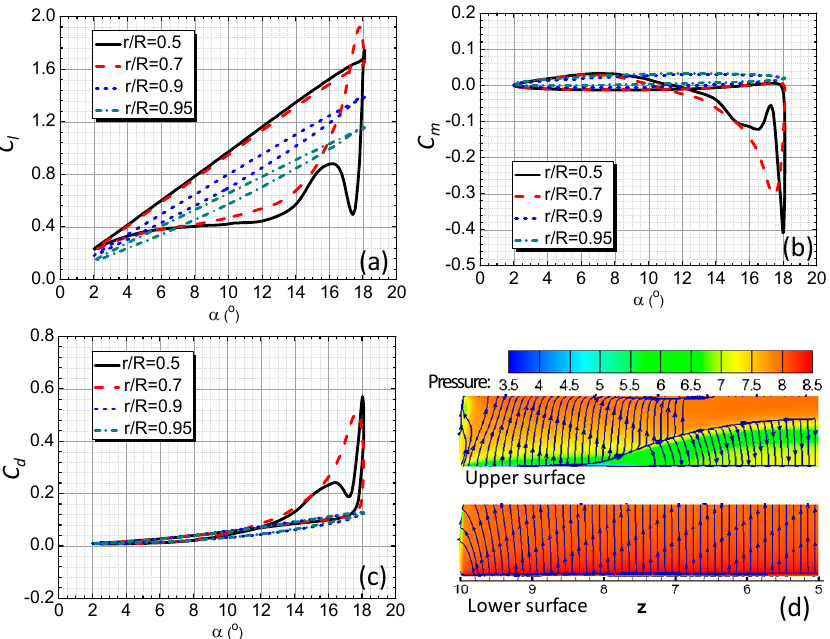
Figure 8. Dynamic ‐ stall loads at different wing sections. ( a ) C l , ( b ) C m , ( c ) C d , ( d ) pressure and streamlines.